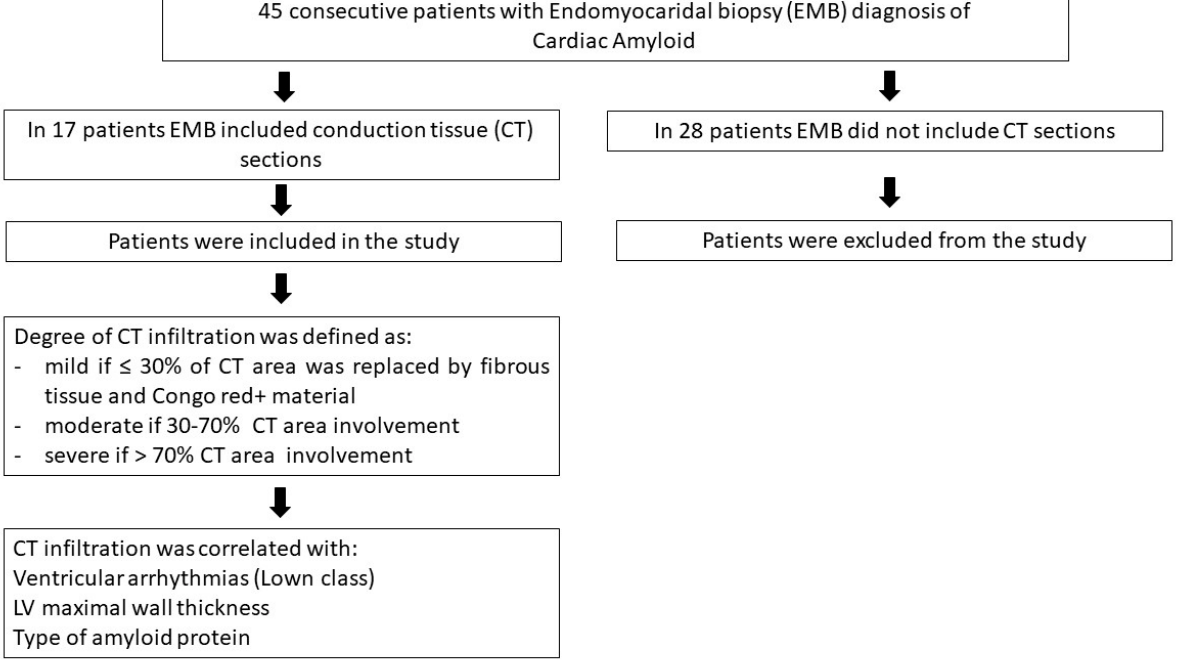
Figure 1. Flow chart of the study.